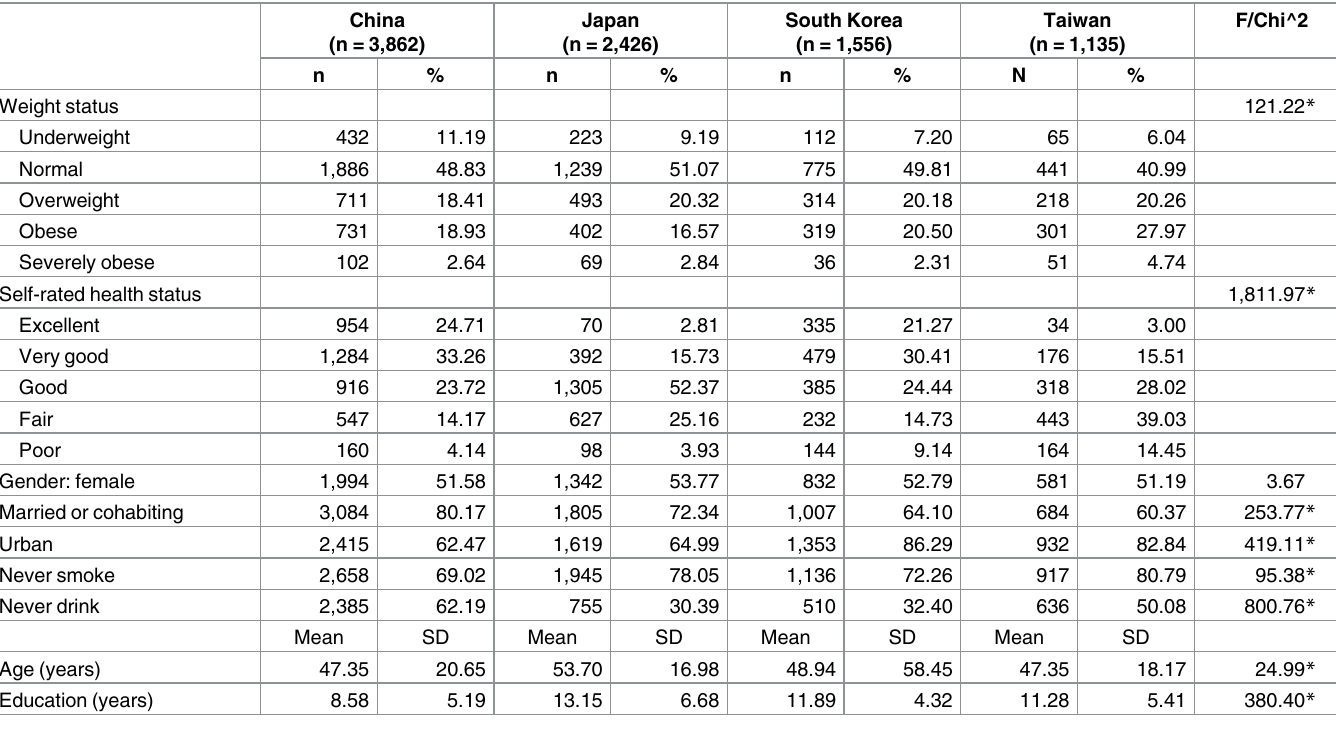
Table 1. Descriptivestatistics.